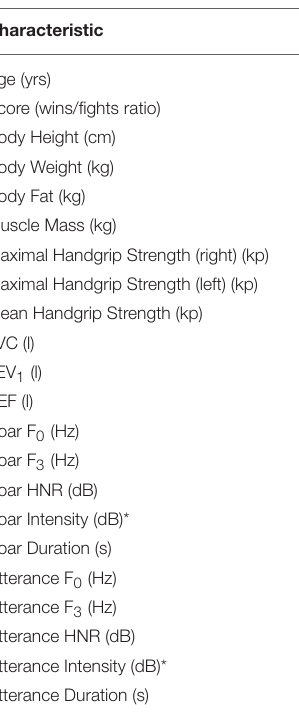
TABLE 1 | Target descriptive